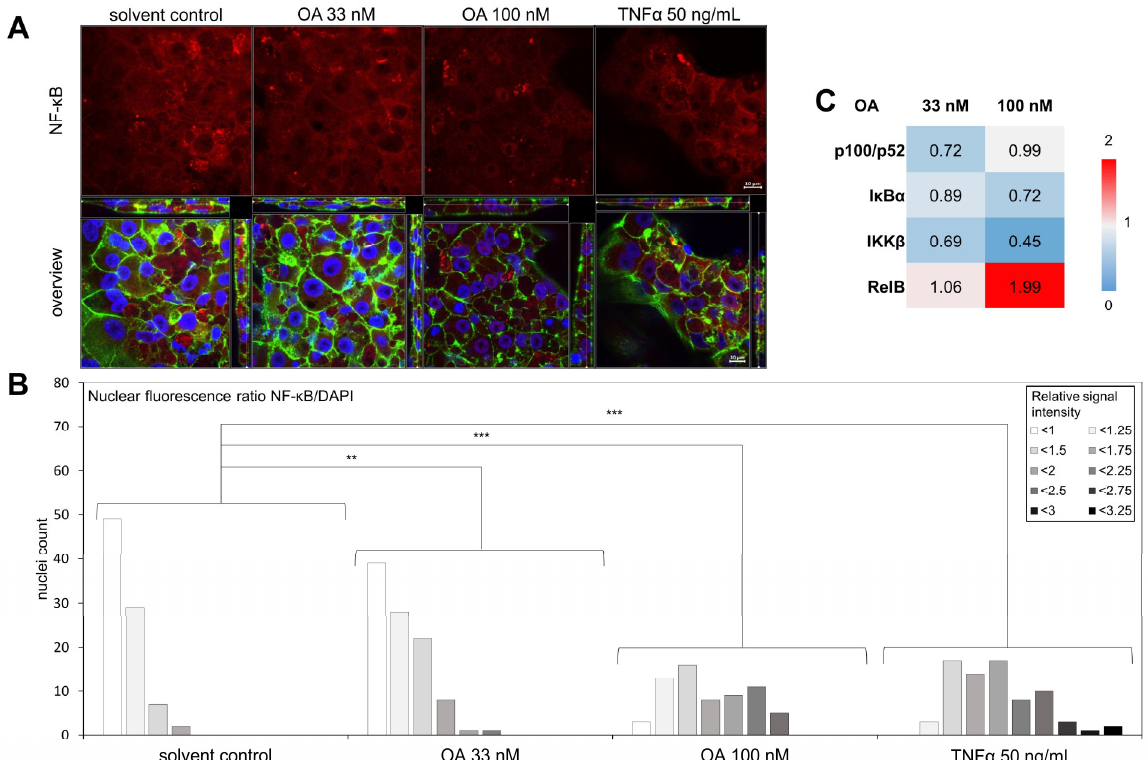
Figure 3. Activation of NF- κ B in HepaRG cells. Differentiated HepaRG cells were treated with 33 and 100 nM OA alone or 33 µ M OA in combination with 30 µ M JSH-23, or 30 µ M Methysticin, two NF- κ B activation inhibitors, or with the respective solvent control for 24 h. ( A ): Nuclei were stained with DAPI, and the actin cytoskeleton was stained using ActinGreen™ 488 ReadyProbes™ reagent. Immunostaining of NF- κ B was carried out using a primary antibody against NF- κ B subunit p65 and stained using a secondary antibody conjugated with the fluorophore Alexa Fluor™ 633. Fluorescence was detected using a confocal laser scanning microscope at ex wavelengths of 405 nm (DAPI, blue), 488 nm (ActinGreen, green), and 633 nm (NF- κ B, red). Z-stacks spanning through the entire cell layer were recorded at 63 × magnification. Brightness was increased by 15% for the green channel, 60% for the blue channel, and 70% for the red channel in each image. ( B ): The nuclear fluorescence ratio was determined using ImageJ 1.53e. Nuclei were marked as ROI and the fluorescence intensity of the red and blue channels in each ROI was determined separately. A ratio of NF- κ B/DAPI signal intensity was then calculated and normalized to the mean of the solvent controls. The nuclei were divided into groups based on their signal intensity. Results show the number of nuclei per signal intensity group for each treatment group. Between 65 and 99 nuclei were evaluated per condition. Statistical analysis was performed using Wilcoxon rank-sum test (** p < 0.01; *** p < 0.001). ( C ): Results of the DigiWest analysis for p100/p52, I κ B α , IKK β , and RelB. Results were obtained using 3 pooled